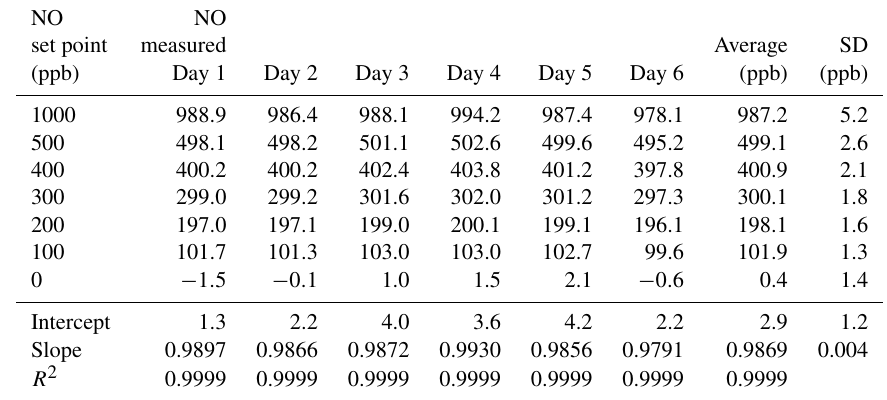
Table 2. Results from the 6 × 6 validation over six consecutive days for the NO photolysis source in the 2B Technologies Model 714 NO 2 / NO / O 3 Calibration Source.